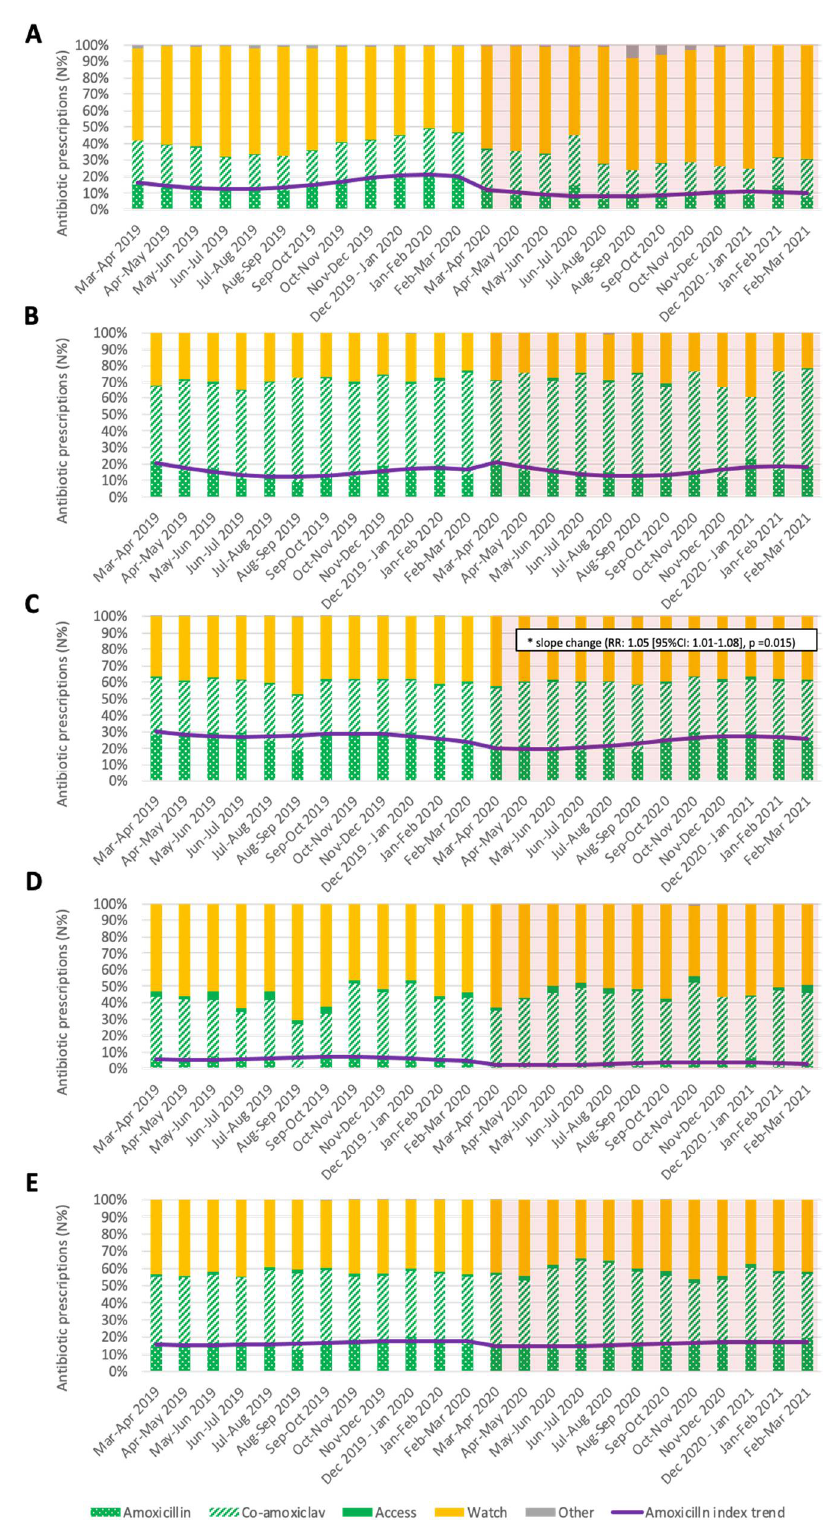
Figure 2. Monthly antibiotic prescriptions in children 0–14 years of age in Italy in the 12 months before and after COVID-19 containment measures implementation by diagnosis class (( A ) LRTI, ( B ) SSTI, ( C ) URTI, ( D ) UTI, ( E ) NA). Pedianet 2019–2021.